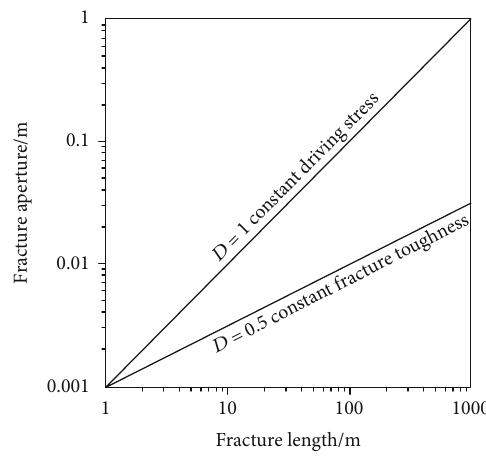
Figure 1: Theoretical scaling of fracture aperture with length for geologic structural discontinuities